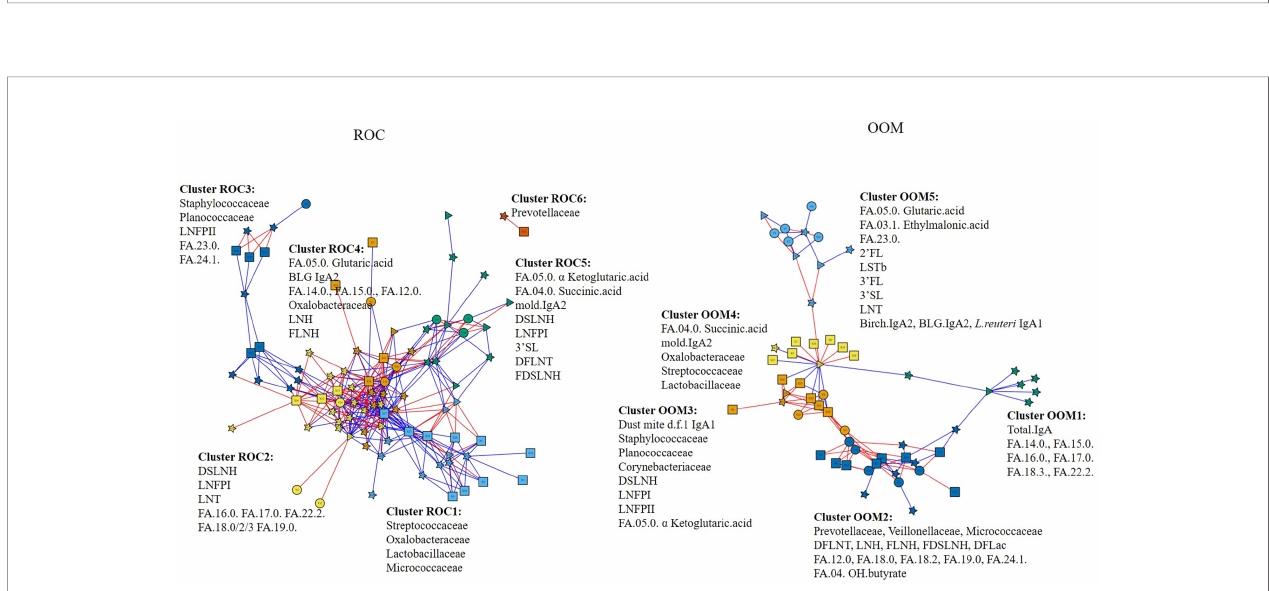
FIGURE 6 | Integrated communities of human milk components in OOM and Rochester populations. Associations between HMOs, fatty acid metabolites, IgA, speci fi c IgA, and milk microbiome were performed using partial least square regression to identify communities in eight Rochester mother (left) and 12 OOM mother (right) populations. Edges represent R 2 > 0.7 for ROC and 0.6 for OOM. Red and blue edges represent positive and negative correlations, respectively. The shapes of the nodes represent the following components: squares, human milk OTUs; circles, HMOs; triangles, IgA; and stars, fatty